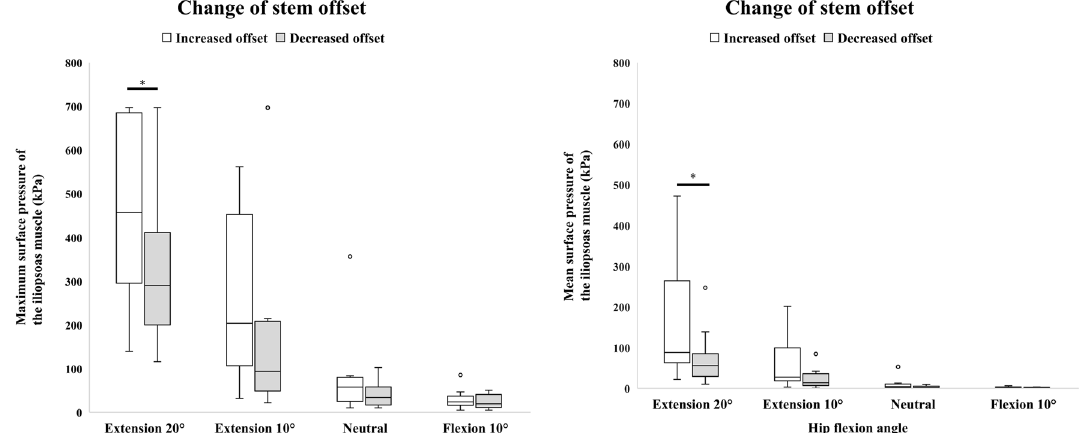
Figure 4. Maximum and mean surface pressure of the iliopsoas muscle when the stem offset was changed. * p < 0.05, ** p < 0.01.